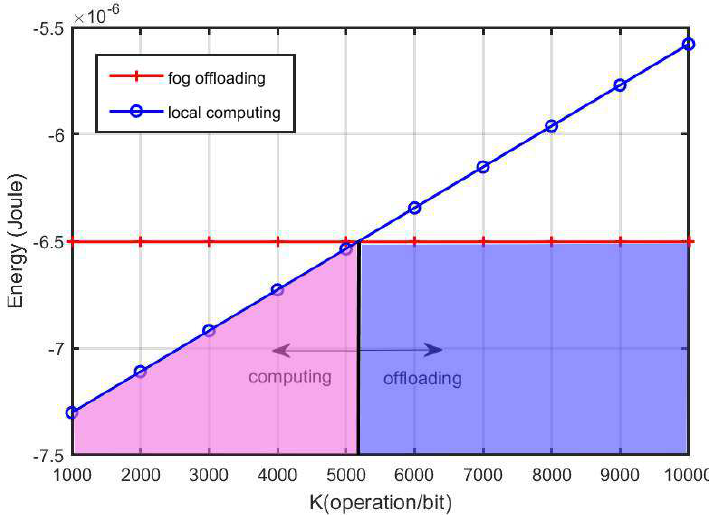
Figure 4. The minimal energy requirement of the two modes versus K .